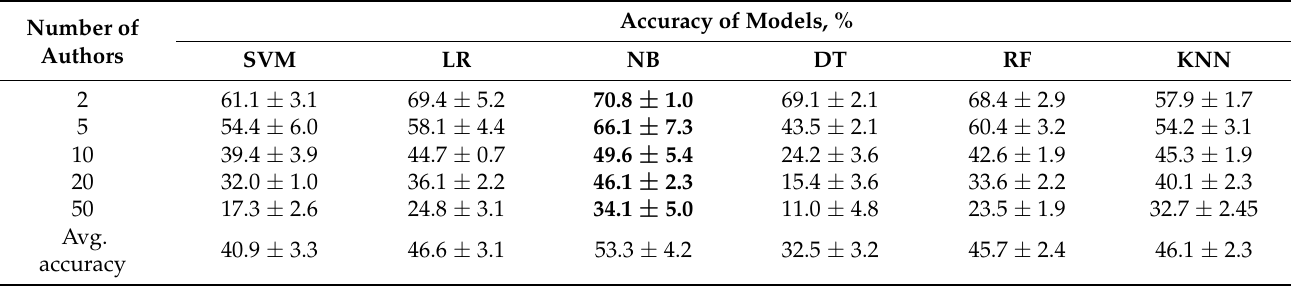
Table 8. Results of author identification using ML trained on the TF-IDF.